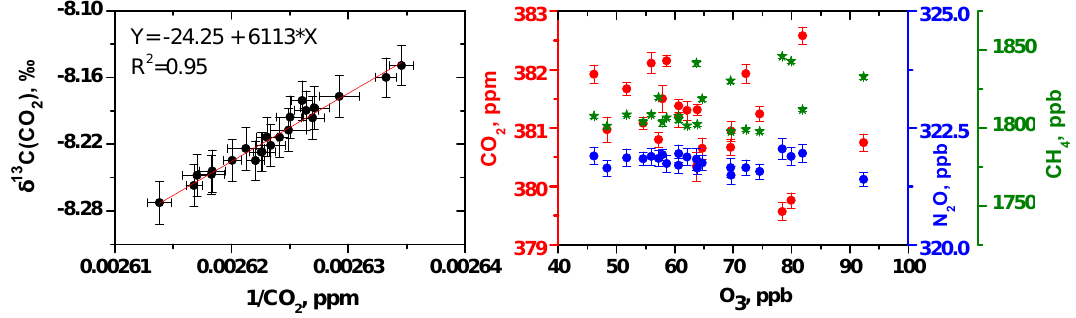
Fig. 10. For a single flight (Frankfurt-Toronto-Frankfurt, September 2007, latitudes 44 to 54 ◦ N) an excellent correlation with an extremely narrow range of δ 13 C(CO 2 ) values was observed for tropospheric air masses. The correlation exists despite the influence of different air masses, evidenced by the variability in methane. Right, GHG data for the same flight plotted vs. O 3 demonstrate stable levels of N 2 O and variable methane.